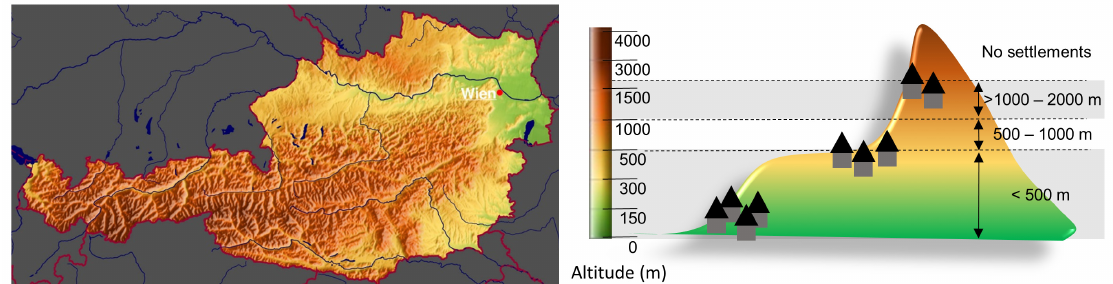
4 of 7 Figure 1. A map depicting altitudes in Austria ( left ) and visualization of the categories of altitude Figure 1. A map depicting altitudes in Austria ( left ) and visualization of the categories of altitude residence used here ( right ); <500 m, 500–1000 m and >1000 m (the highest Austrian villages are at residence used here ( right ); <500 m, 500–1000 m and >1000 m (the highest Austrian villages are at Table 2. Altitude-dependent mortality rates for both sexes of the overall population and those aged about 2000 m). The map has been obtained from http://www.ginkomaps.com, accessed on 13 March about 2000 m). The map has been obtained from http://www.ginkomaps.com, accessed on 13 March 60+ (per 100,000 of the respective population; and 95% confidence intervals) from all causes and 2022 and modified. Wien (Vienna); capital of Austria. 2022 and modified. Wien (Vienna); capital of Austria. from COVID-19 in 2020. Table 1. Altitude-dependent numbers (for both sexes) of the overall population and those aged above Altitude-dependent numbers of the population for both sexes and respective num- Mortality Rate from all Mortality Rate from 60 years, and respective numbers of deaths from all causes and from COVID-19 in 2020. bers of deaths from all causes and those from COVID-19 in 2020 are shown in Table 1. Causes COVID-19 Deaths Deaths Table 1. Altitude-dependent numbers (for both sexes) of the overall population and those aged Altitude Age Group Sex Population from All Causes from COVID-19 above 60 years, and respective numbers of deaths from all causes and from COVID-19 in 2020. Males Age Altitude Overall Group <500 m